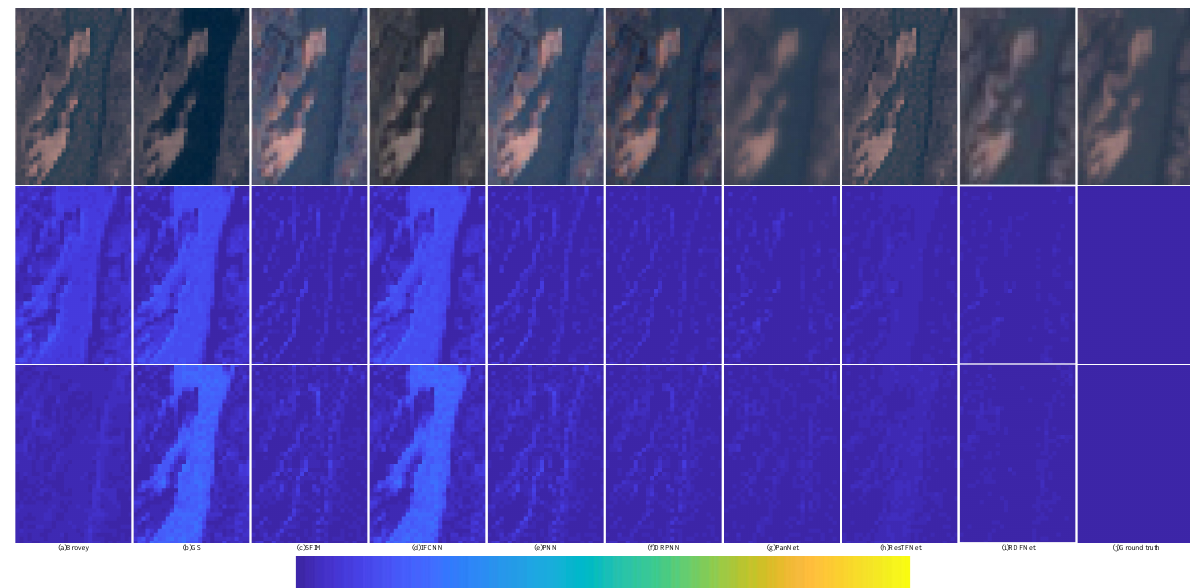
Figure 20. Enlarged view of the yellow box in Figure 18, the corresponding average intensity difference maps, and the average spectral difference maps; the top row are the enlarged views of the yellow box in Figure 18, the middle row are average intensity difference maps, the bottom row are average spectral difference maps. ( a ) Brovey; ( b ) GS; ( c ) SFIM; ( d ) IFCNN; ( e ) PNN; ( f ) DRPNN; ( g ) PanNet; ( h ) ResTFNet; ( i ) RDFNet (ours); ( j ) ground